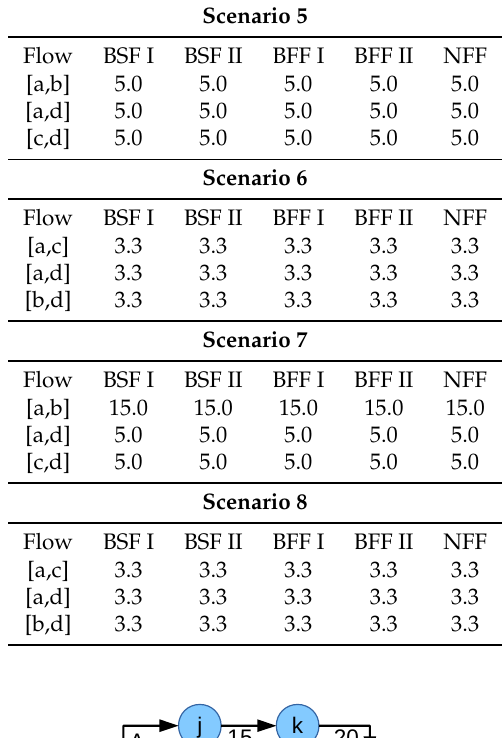
Table 3. Flow set and LP results for the flows’ end-to-end throughput for scenarios 5 to 8 described in Figure 14. All values in Mbps.